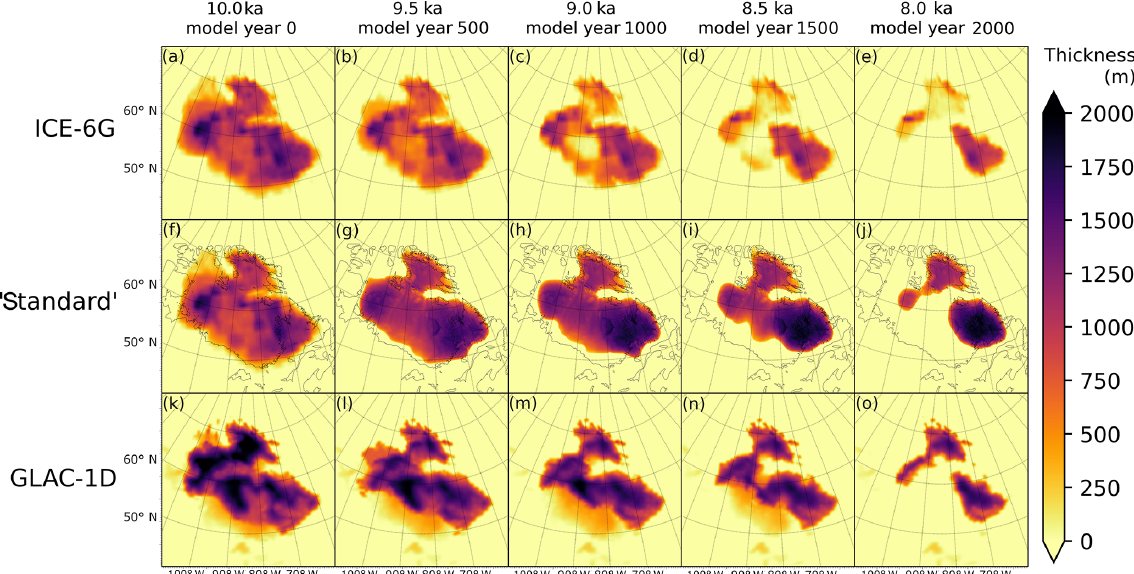
Figure 5. Ice sheet thickness evolution in the ICE-6G_c (VM5a; Peltier et al., 2015) reconstruction in panels (a) – (e) , the standard simulation in panels (f) – (j) and the GLAC-1D reconstruction (Tarasov et al., 2012) in panels (k) – (o) . The ice thickness in each series is plotted in 500 year intervals. The coastlines plotted in panels (f) – (j) are based on the ETOPO 10ka topography described in Sect.